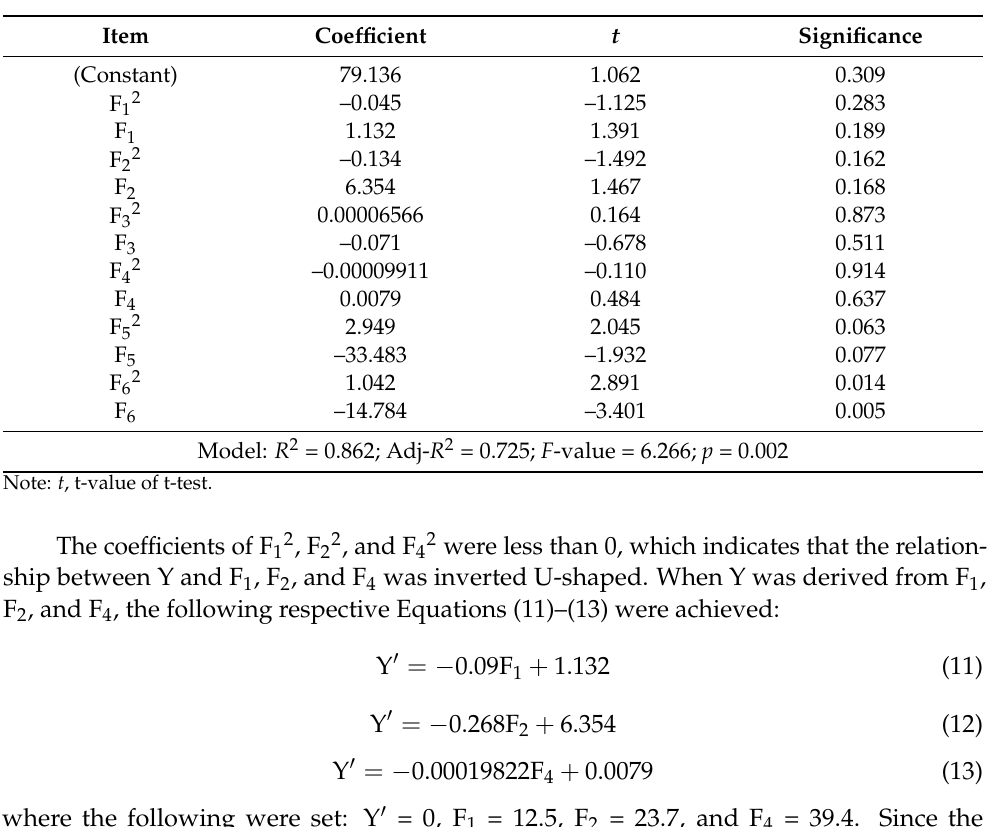
Table 6. Orthogonal experimental analysis of culture condition